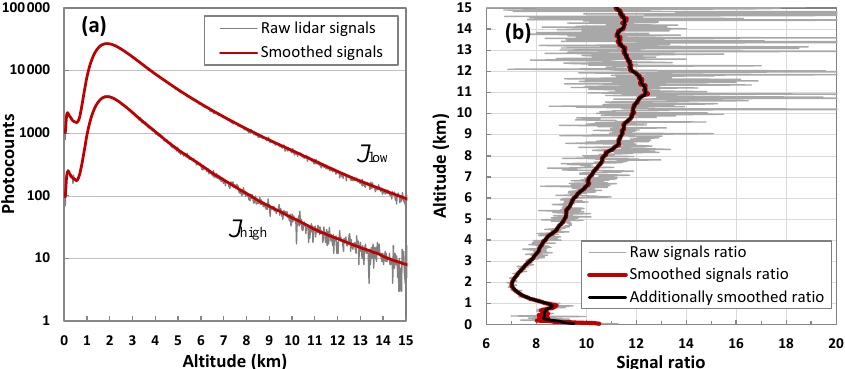
Figure 3. IMCES lidar data taken between 03:45 and 05:15LT on 1 April 2015 (31 March, 21:45–23:15UTC). (a) Raw photocounts N L and N H detected in the lidar channels with J low and J high , respectively, together with the single-averaged ones N L and N H . (b) Raw photocounts ratio Q = N L / N H , single-averaged photocounts ratio Q = N L /N H , and additionally averaged ratio Q I = Q = N L /N H